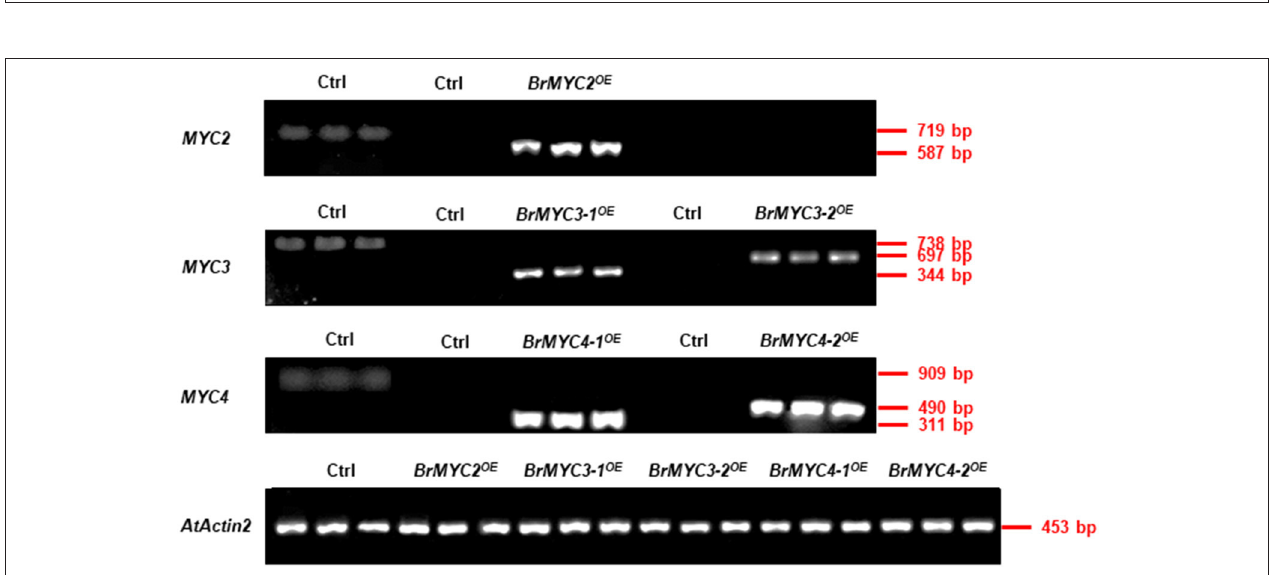
FIGURE 8 | Inhibition of S. sclerotiorum growth by the lyophilized powder of each transgenic A. thaliana line on PDA. From left to right are: ddH 2 O, Ctrl, BrMYC2 OE , BrMYC3-1 OE , BrMYC3-2 OE , BrMYC4-1 OE , and BrMYC4-2 OE . One sclerotium of S. sclerotiorum was placed in the center of each dish. Fungal hyphae growth was visible as white cottony mycelium plaque. Bar = 1cm.